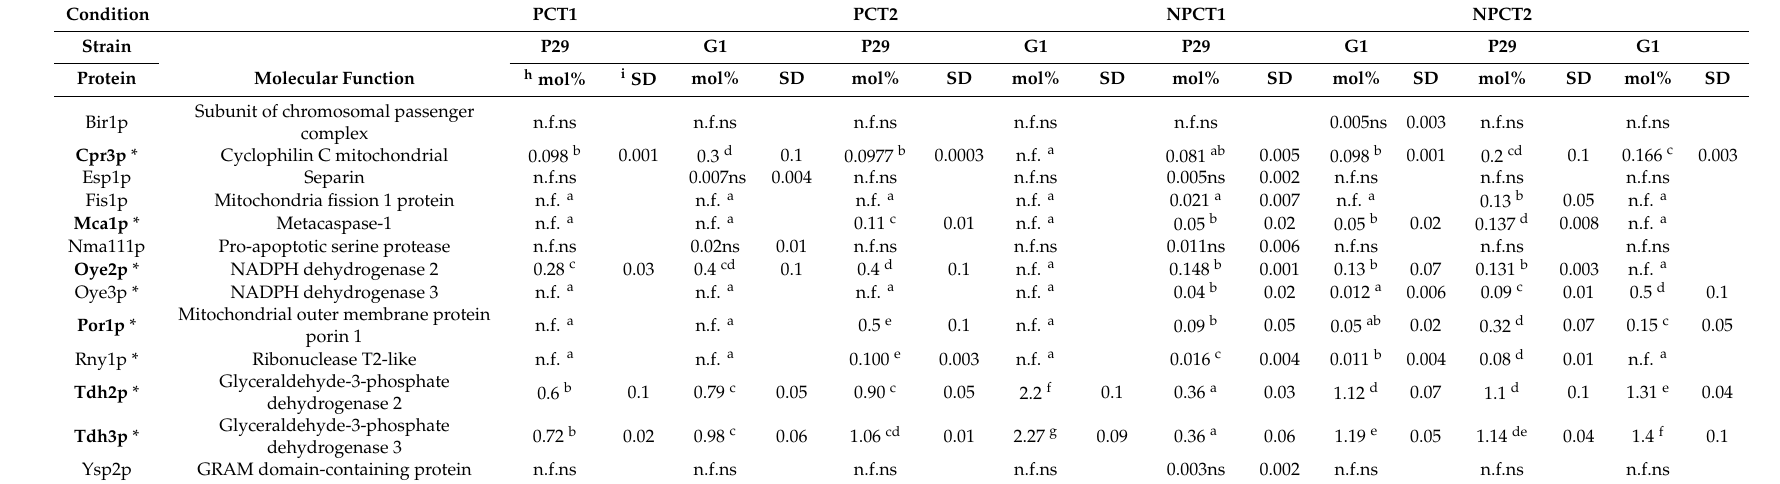
Table 2. List of the most relevant apoptosis-related proteins identified in S. cerevisiae P29 and G1 under each study condition (PC: pressure condition, NPC: non-pressure condition) and sampling time (T1: middle of the second fermentation, T2: 1 month after it). Proteins showing a high content are highlighted in bold. a–g Di ff erent superscript letters indicate significant di ff erences of protein content in each condition at 0.05 level according to Fisher’s least significant di ff erence procedure. Proteins showing significant di ff erences in all conditions are marked with an asterisk *. n.f.; not found. ns.; not